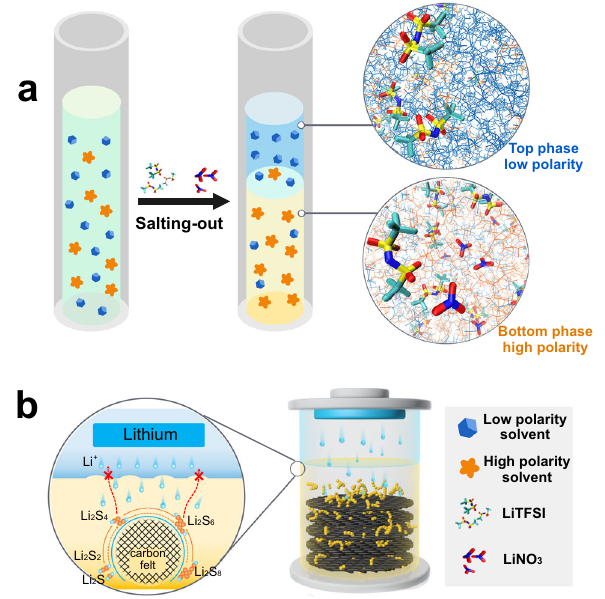
Fig. 1 | Schematic illustration ofLi-SBSBs. a Strati fi cationphenomenonbetween low polarity solvents and high polarity solvents salted-out by LiTFSI and LiNO 3 . b Schematic representation ofLi-S BSBs, in which LPSs are con fi ned to the bottom phase during charge and